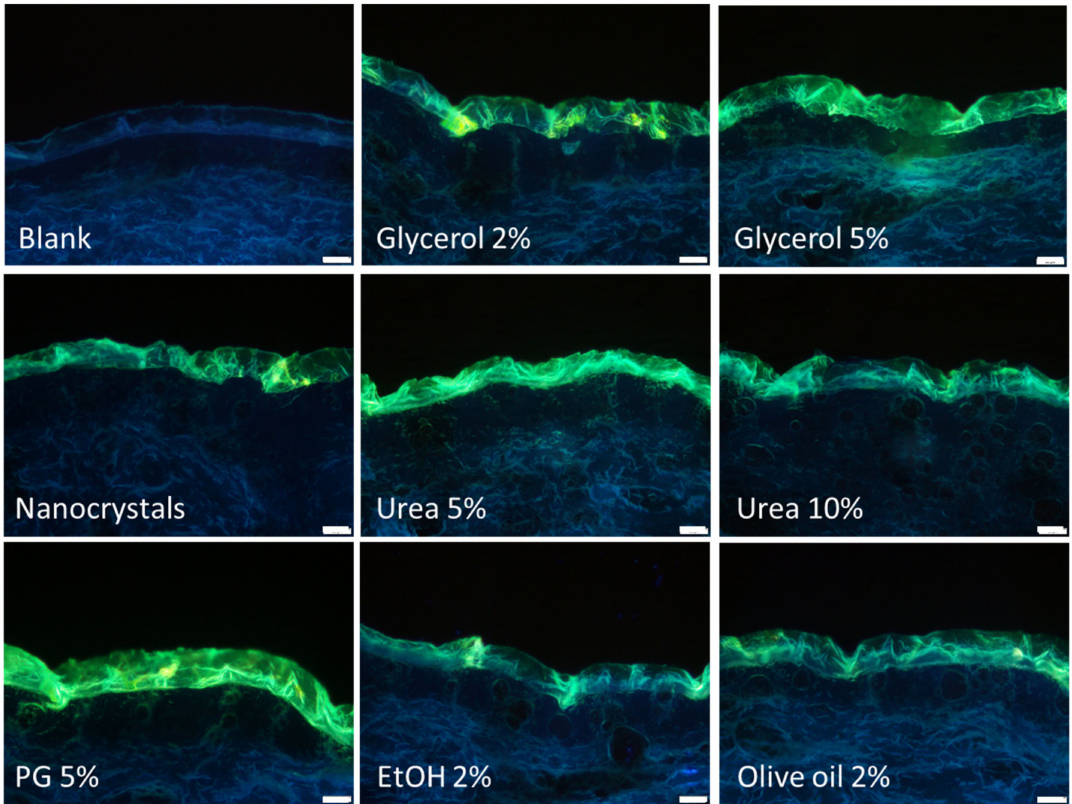
Figure 2. Influence of excipients on passive, dermal penetration of curcumin from drug nanocrystals. Representative images from vertical skin sections. Non-treated (Blank), treated with aqueous nanosuspension without further excipients and treated with curcumin nanosuspensions that contained di ff erent excipients, i.e., glycerol 2% and 5%, urea 5% and 10%, propylene glycol 5%, ethanol 2%